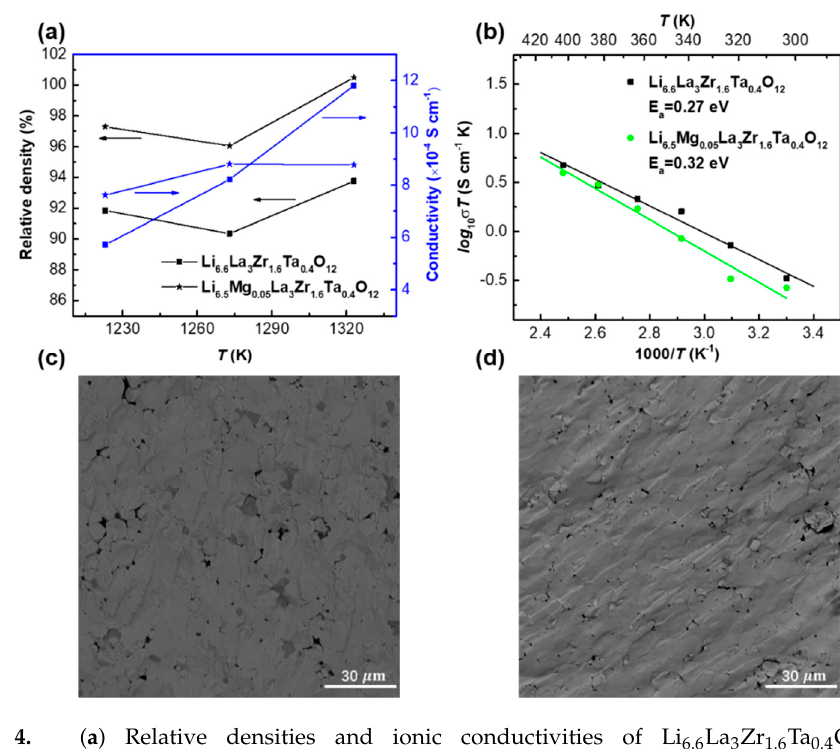
Figure 4. ( a ) Relative densities and ionic conductivities of Li 6.6 La 3 Zr 1.6 Ta 0.4 O 12 and Li 6.5 Mg 0.05 La 3 Zr 1.6 Ta 0.4 O 12 sintered by SPS at different temperatures. ( b ) Arrhenius plots of total ionic conductivities of Li 6.6 La 3 Zr 1.6 Ta 0.4 O 12 and Li 6.5 Mg 0.05 La 3 Zr 1.6 Ta 0.4 O 12 sintered by SPS. The dash points are experimental values and the solid lines are the fitting ones. The cross-section SEM of Li 6.6 La 3 Zr 1.6 Ta 0.4 O 12 ( c ) and of Li 6.5 Mg 0.05 La 3 Zr 1.6 Ta 0.4 O 12 ( d ) after conducting SPS at 1000 ◦